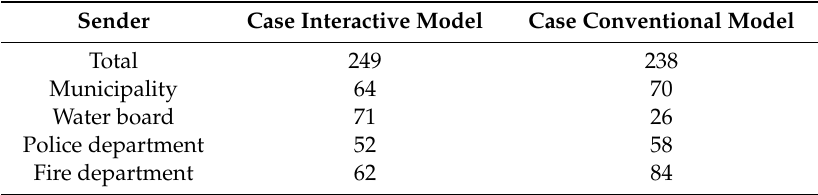
Table 3. Indicator 3: Participation of di ff erent stakeholders with and without the use of an interactive model, monitored by the number of statements per stakeholder. Statements were only counted if they were a response on earlier statements and had had full attention of the